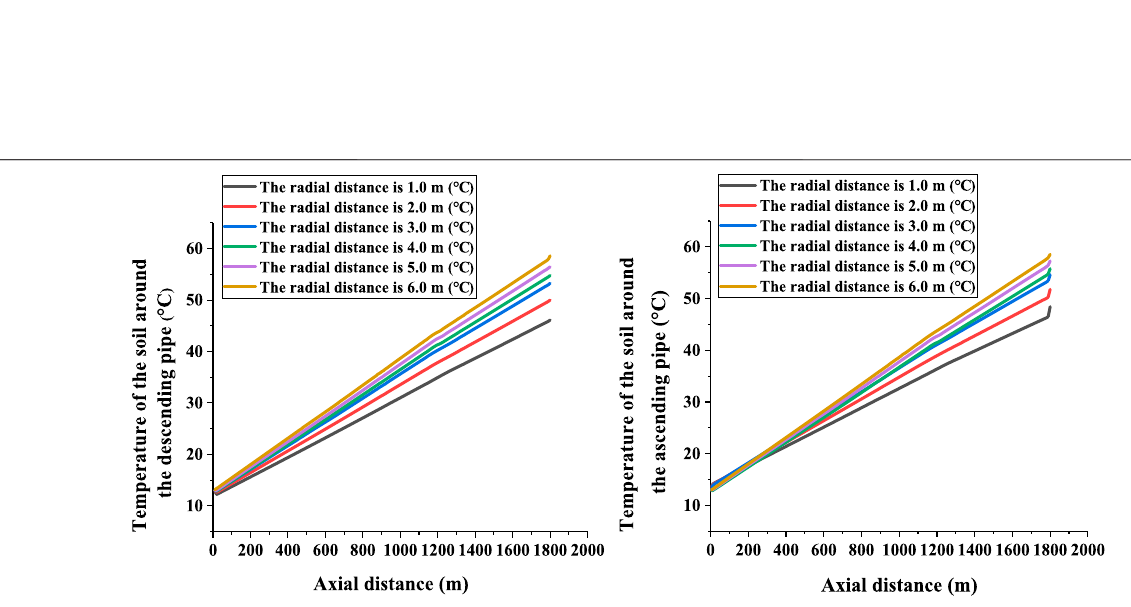
Frontiers in Energy Research |